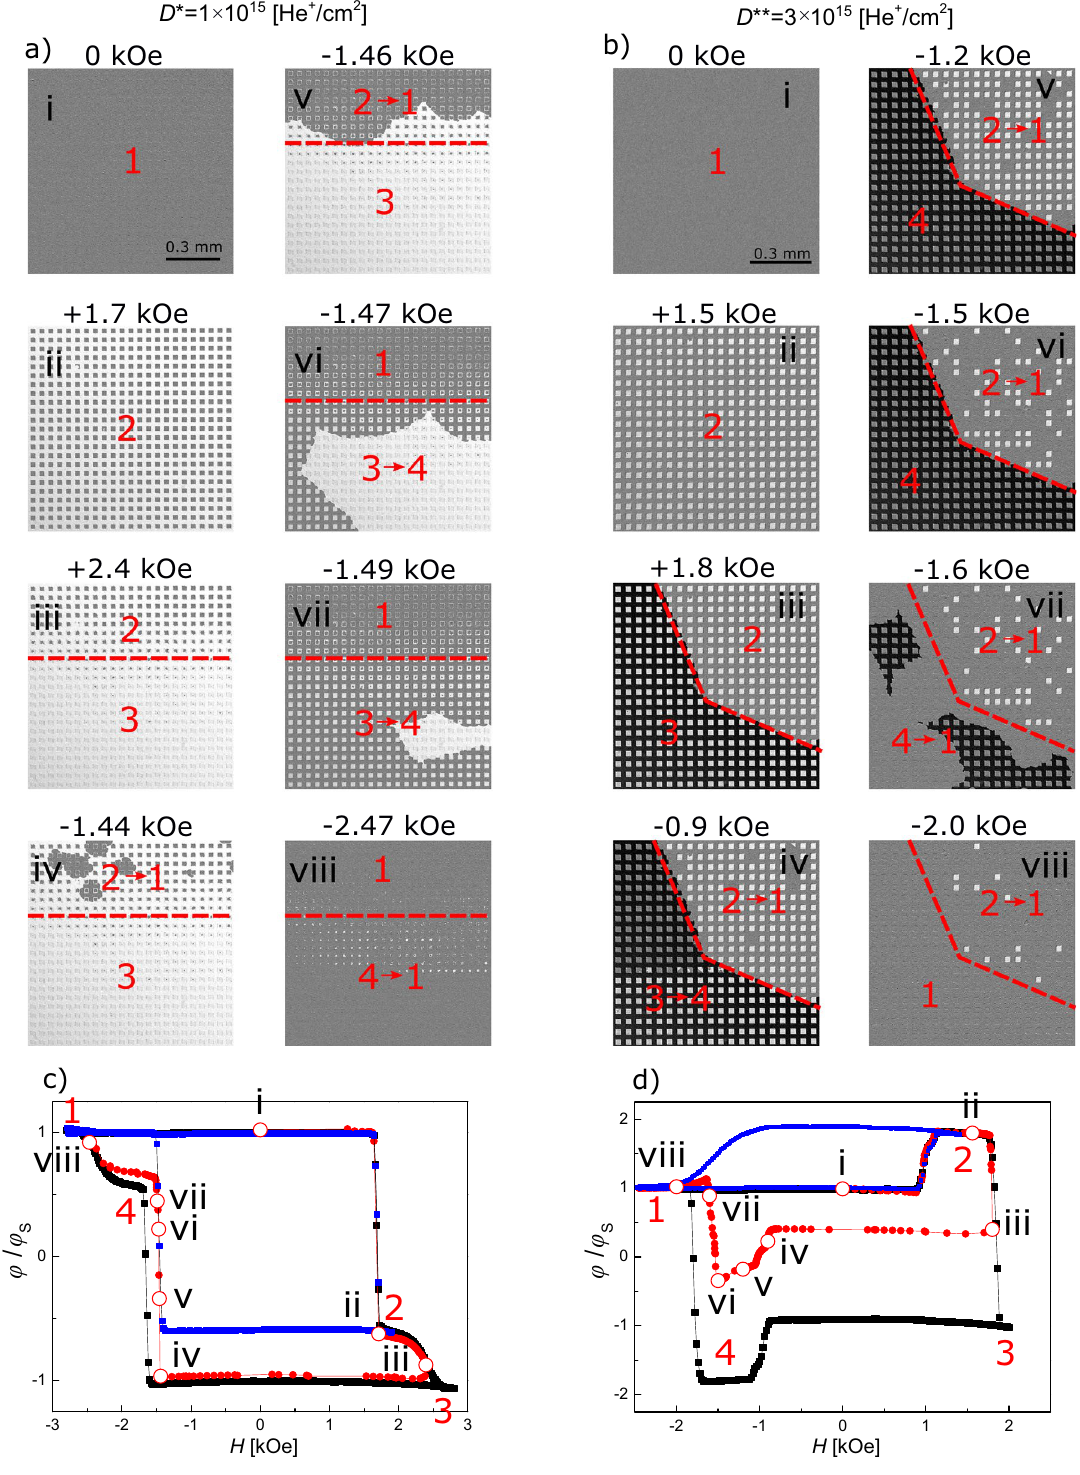
Figure 9. ( a , b ) Representative differential images illustrating the magnetization evolution in lattices of squares with a = 25 μm (sample B2) during minor loop reversal starting from saturation in negative magnetic field. The maximum positive field was chosen to induce a partial reversal of the magnetically hard areas (i.e., either the squares for D* lattices or the matrix for D** lattices). ( c , d ) Hysteresis loops obtained from gray values of the images of IB modified lattices (major loop in black, minor in blue, and red for the loop shown in the two top panels). The left column of the figure ( a , c ) corresponds to data obtained from D* lattices; the right side ( b , d ), to data from